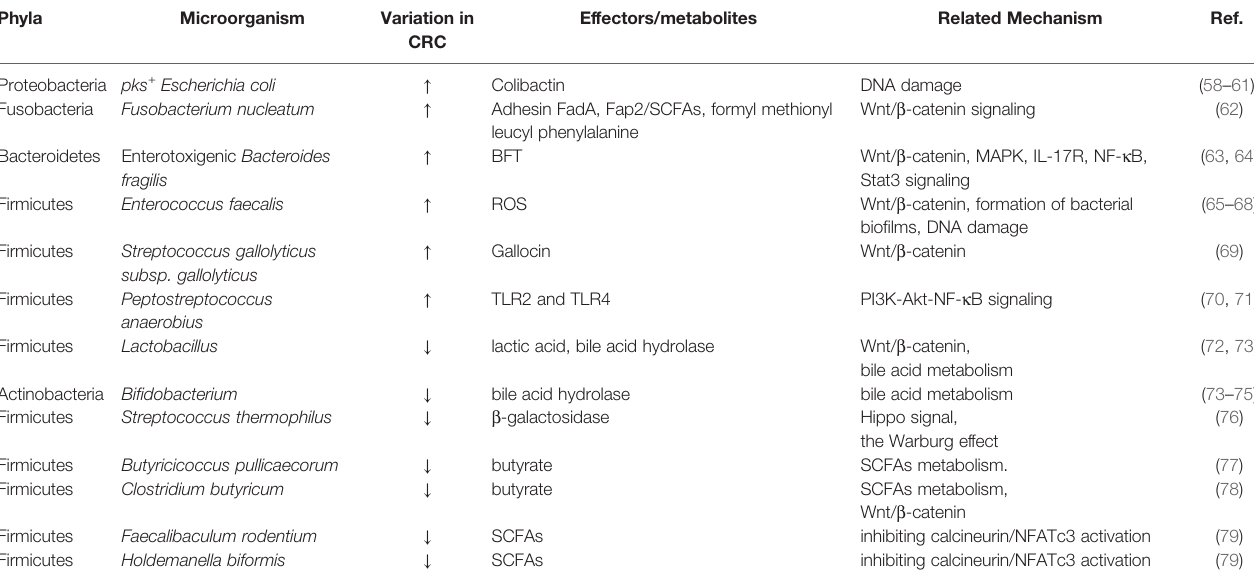
TABLE 1 | Studies of gut bacteria associated with the development of adenoma and/or